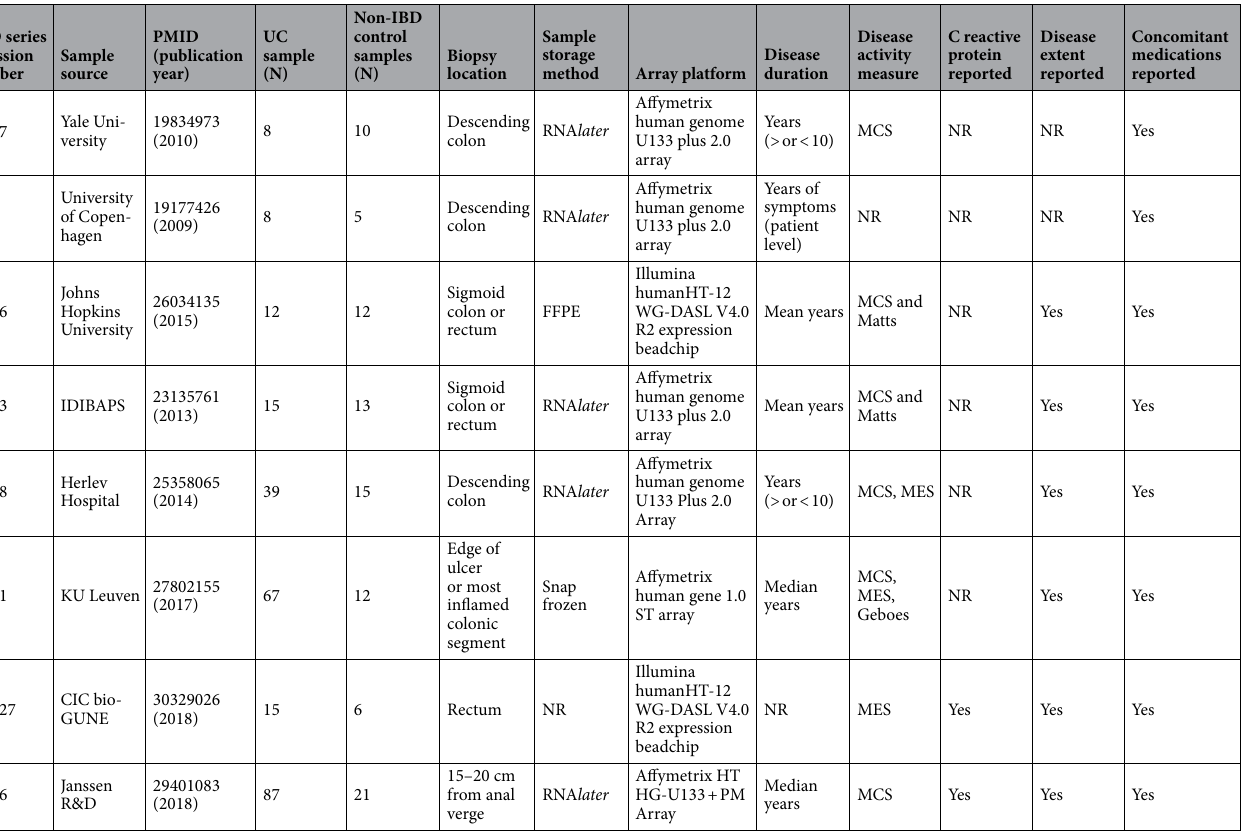
Table 1. Microarray data series used for meta-analysis. FFPE formalin-fixed and paraffin-embedded, GEO Gene Expression Omnibus, PMID PubMed unique identifier, IBD inflammatory bowel disease, MCS